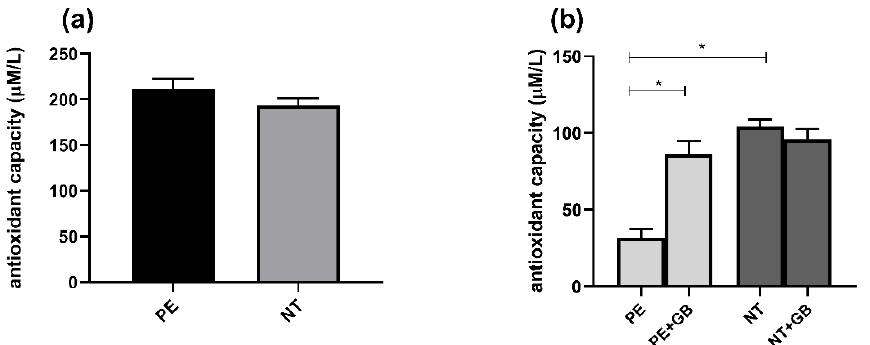
Figure 6. Ferric-reducing antioxidant power (FRAP) activity in plasma from PE and NT pregnant women ( a ) and in the supernatant of HUVEC culture with plasma and GB ( b ). Three independent experiments with replicates of 5 per group in each experiment. Data are presented as mean ± SEM. Mann–Whitney U test ( a ) and (ANOVA) followed by the Tukey’s Test ( b ). * ( p < 0.05).